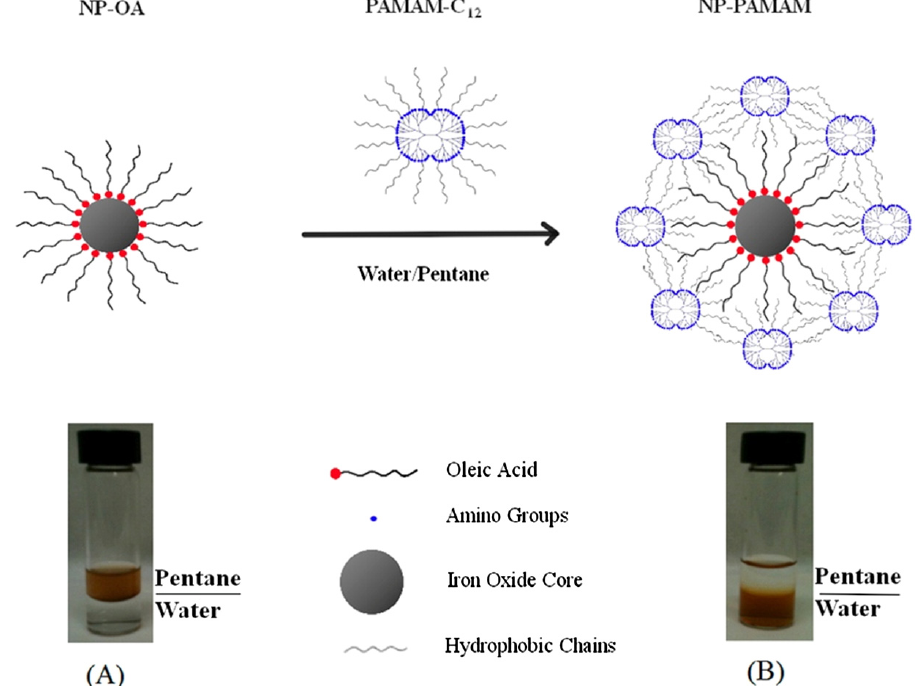
Figure 4. Micelle approach for PAMAM-C12 coating of the oleic acid-capped iron oxide nanoparticles. Reproduced with permission from [142]. Copyright 2013, American Chemical